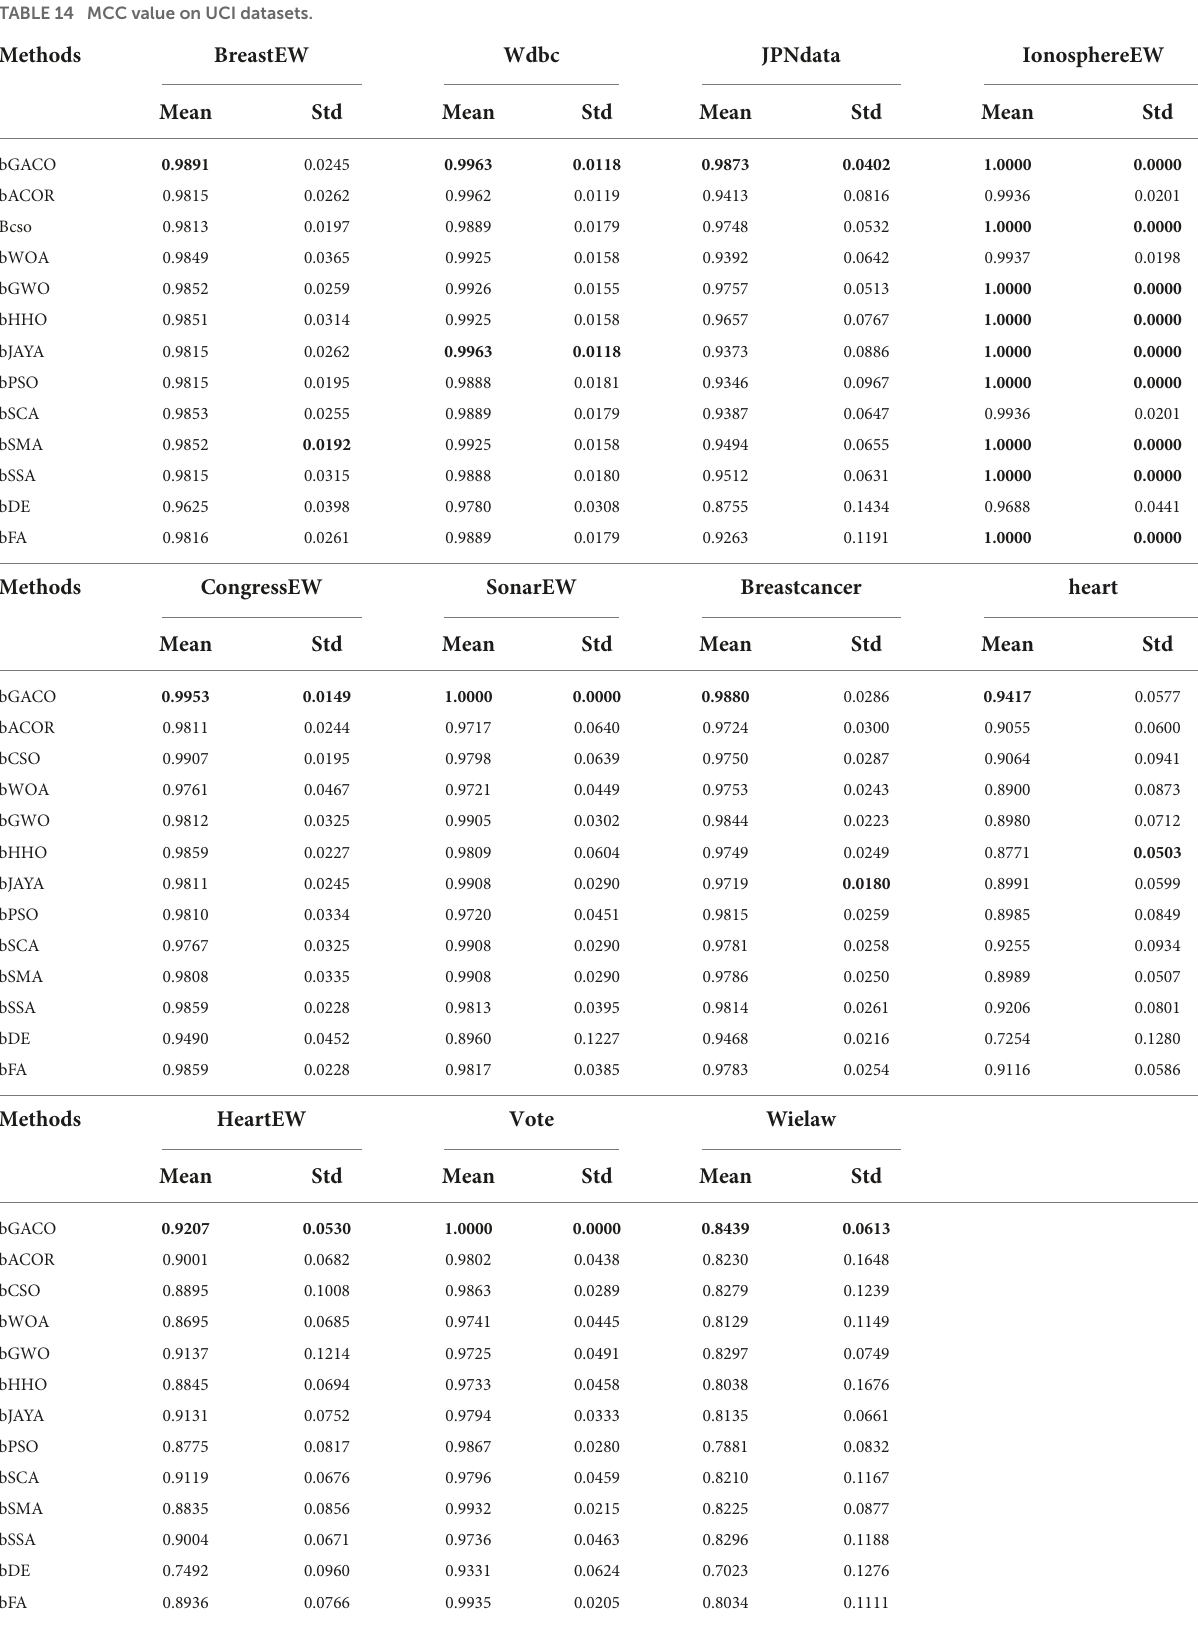
TABLE 14 MCC value on UCI